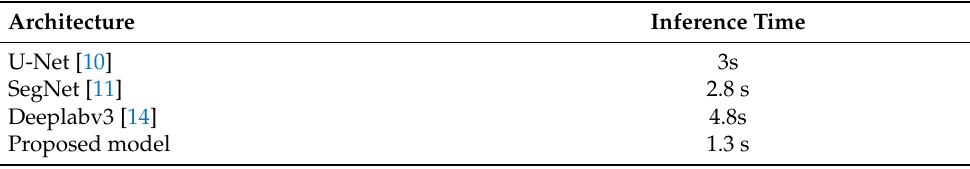
Table 19. Inference